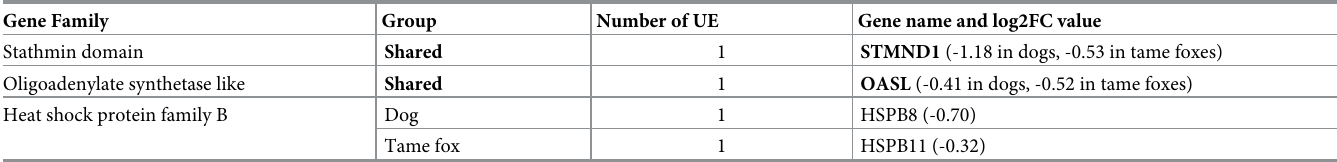
Table 2. Shared genes and gene families (Down regulation). List of the gene families, and shared genes, that were commonly down regulated in dogs and tame foxes. The number, and name, of the genes within each gene family are provided, with the corresponding log2fold-change values in brackets for each species. Within each family, single genes were characterized as shared between dogs and tame foxes, or as exclusively to each of the two groups. When more than one transcript for a specific gene was present, all the log2FC values are